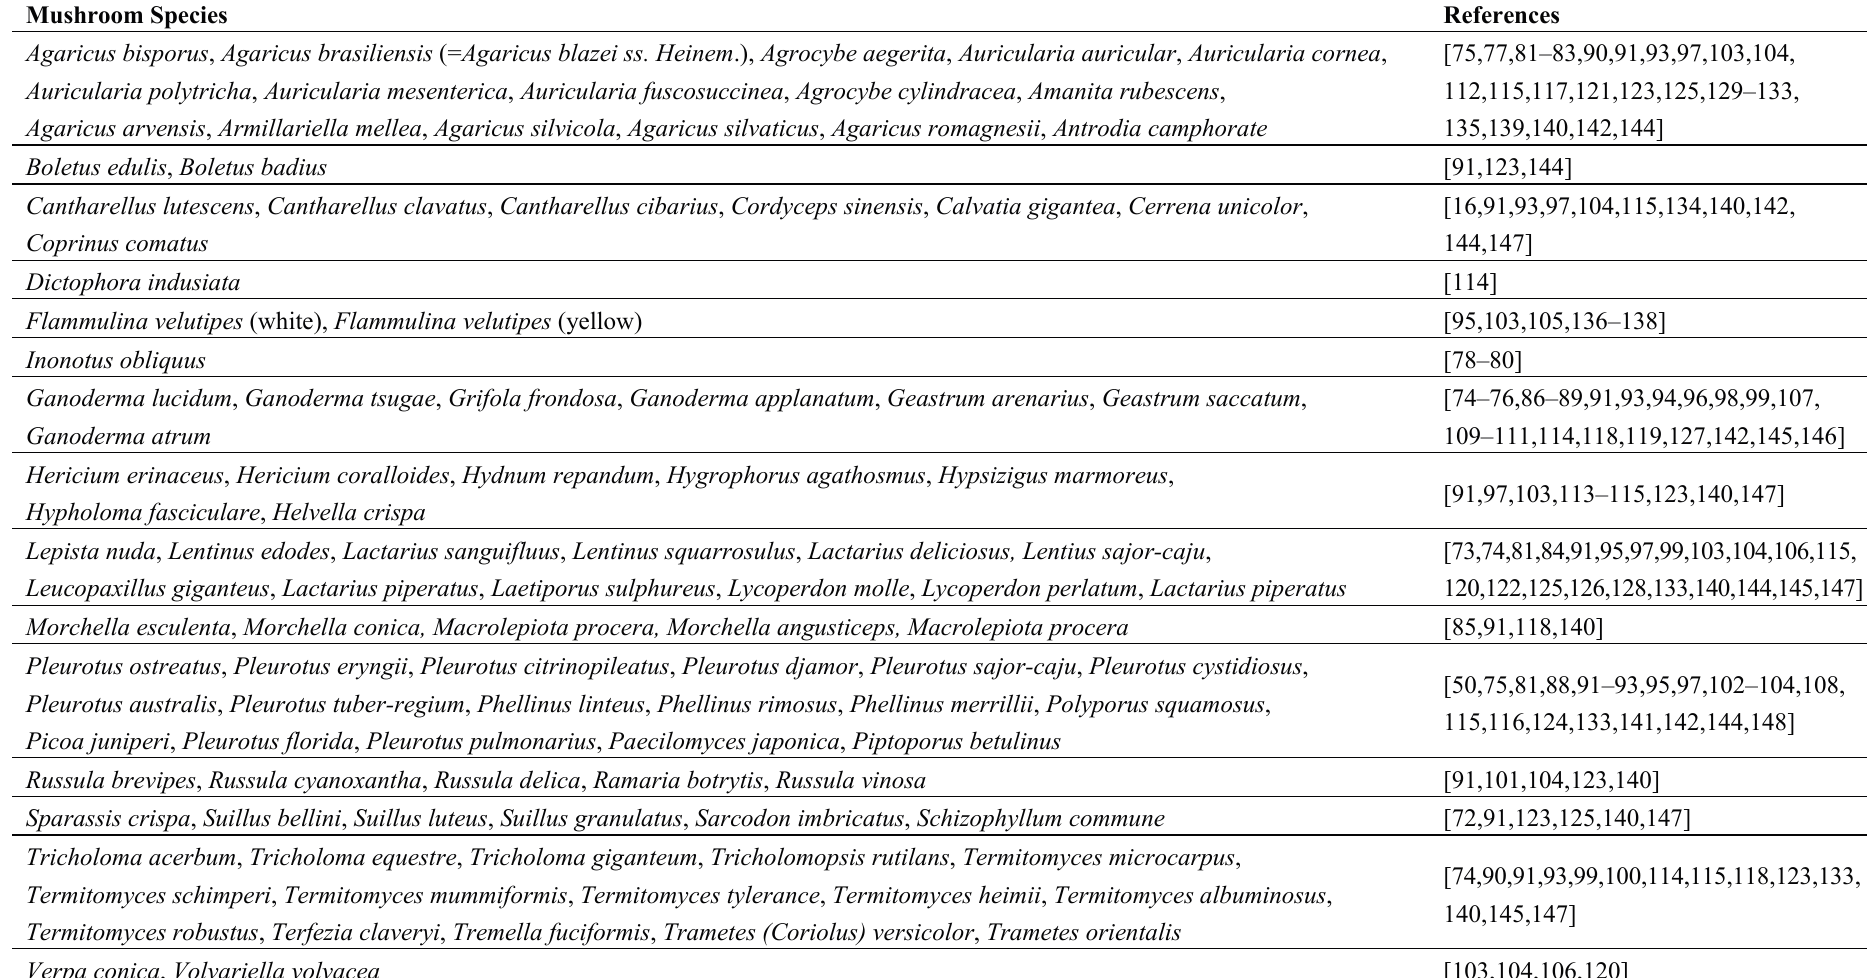
Table 2. Some studies of antioxidative properties of wild and cultivated